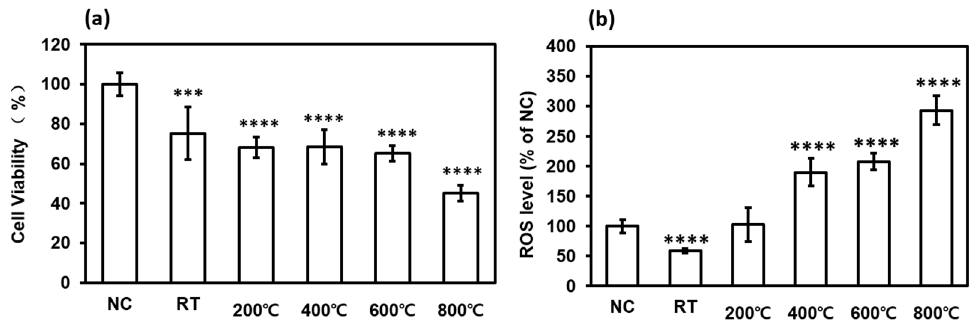
Figure 8. ( a ) Cell viability and ( b ) ROS production in the naïve control (NC) and synthesized aBC-stimulated A549 cells. Data are presented as the mean ± SD (n = 8). *** p < 0.01 and **** p < 0.001 compared to the NC.